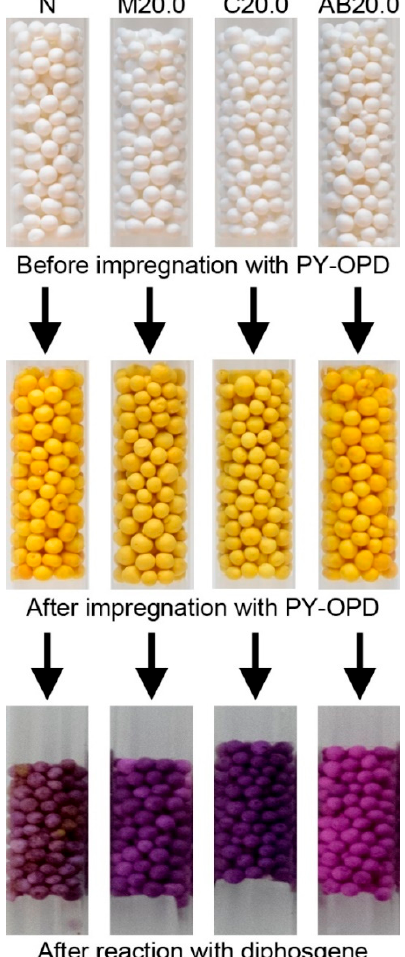
Figure 5. Comparison of the appearance of selected samples before impregnation with the detection reagent PY ‐ OPD, after their impregnation and after their reaction with diphosgene in the visible light spectrum.